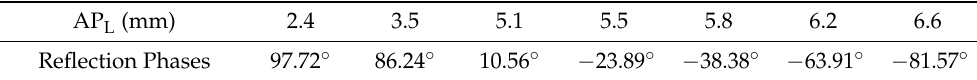
Table 1. Gradient aperture lengths (AP L ) and corresponding reflection phases.